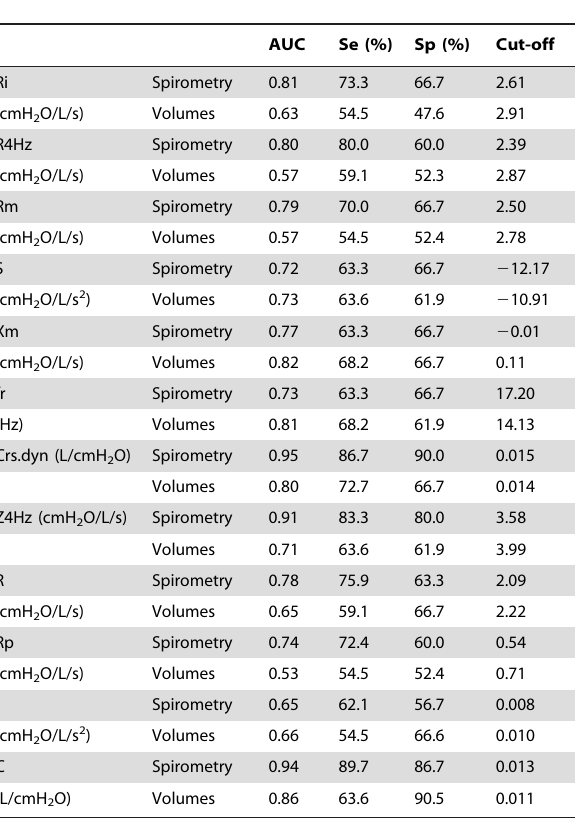
Table 6. Values of area under the curve (AUC), sensitivity (Se) and specificity (Sp) for the optimal cut-off points for the FOT indices describing the performance of FOT parameters in the detection of patients considered restrictive according to the spirometric and volumetric